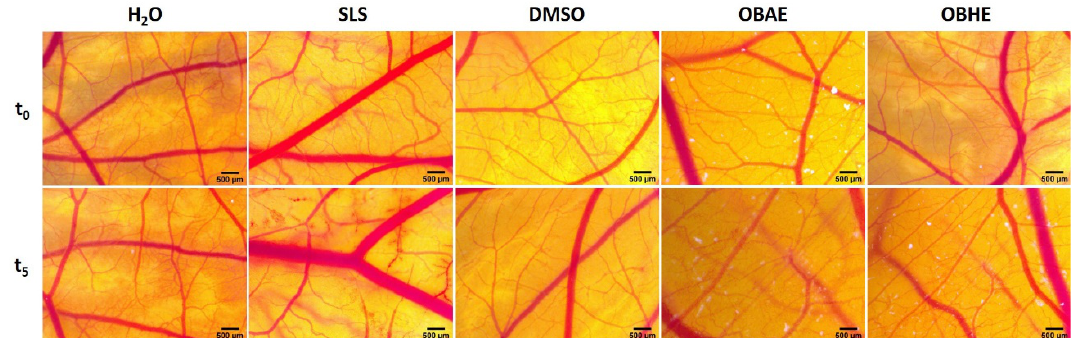
8 of 23 Figure 3. Viability percentage of human melanoma A375 cells after stimulation with basil hydro-alcoholic extracts (25, 50, 75 and 150 μg/mL), at 24 h post-stimulation. The results are expressed as cell viability percentage (%) normalized to control cell. The data represent the mean value ±SD obtained from three independent experiments performed in triplicate. One-way ANOVA analysis was applied to determine the statistical differences in rapport with positive control-treated cells followed by the Tukey’s test (*** p <0.001 and **** p <0.0001). 2.4. In Ovo Assessment of Hydro-Alcoholic Basil Extracts The HET-CAM (hen’s egg chorioallantoic membrane) method was used to evaluate biocompatibility and to explore the potential irritability induced on irrigated mucosal tissues by hydro-alcoholic basil extracts. The assessment involved monitoring the potential haemorrhage, coagulability or blood vessel lysis when exposed to sample solution for the duration of 5 min. Both extracts tested at the highest concentration considered for this study (150 μg/mL) induced a very